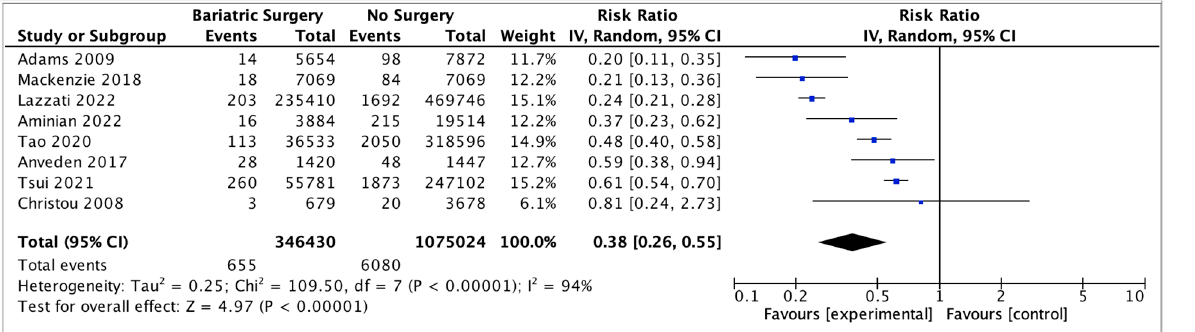
Figure 7. Endometrial cancer incidence [38,39,43,45,49,50,53,55].